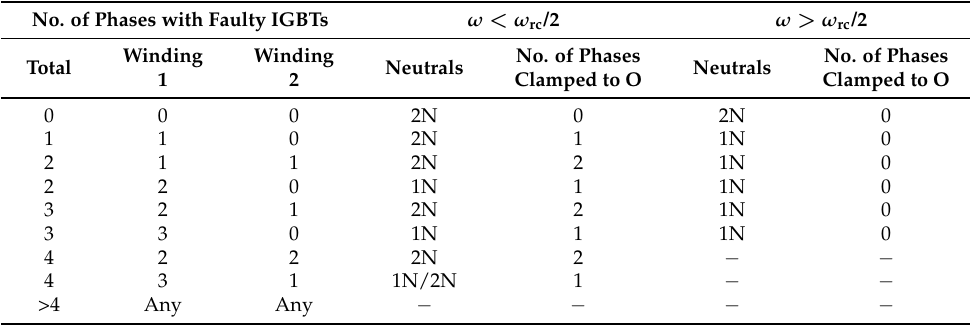
| -speed region under IGBT OC faults in phases a and d of an asymmetrical six-phase Figure 14. A | i αβ 1 machine, if both phases are kept open with single neutral point ( left ), both of them are clamped to O with separate neutral points ( center ), and for the method based on alternating between these modes depending on the speed ( right ) [24]. Table 21. Configurations (neutral points and clamped phases) proposed in [24] for an asymmetrical six-phase machine depending on speed and faulty